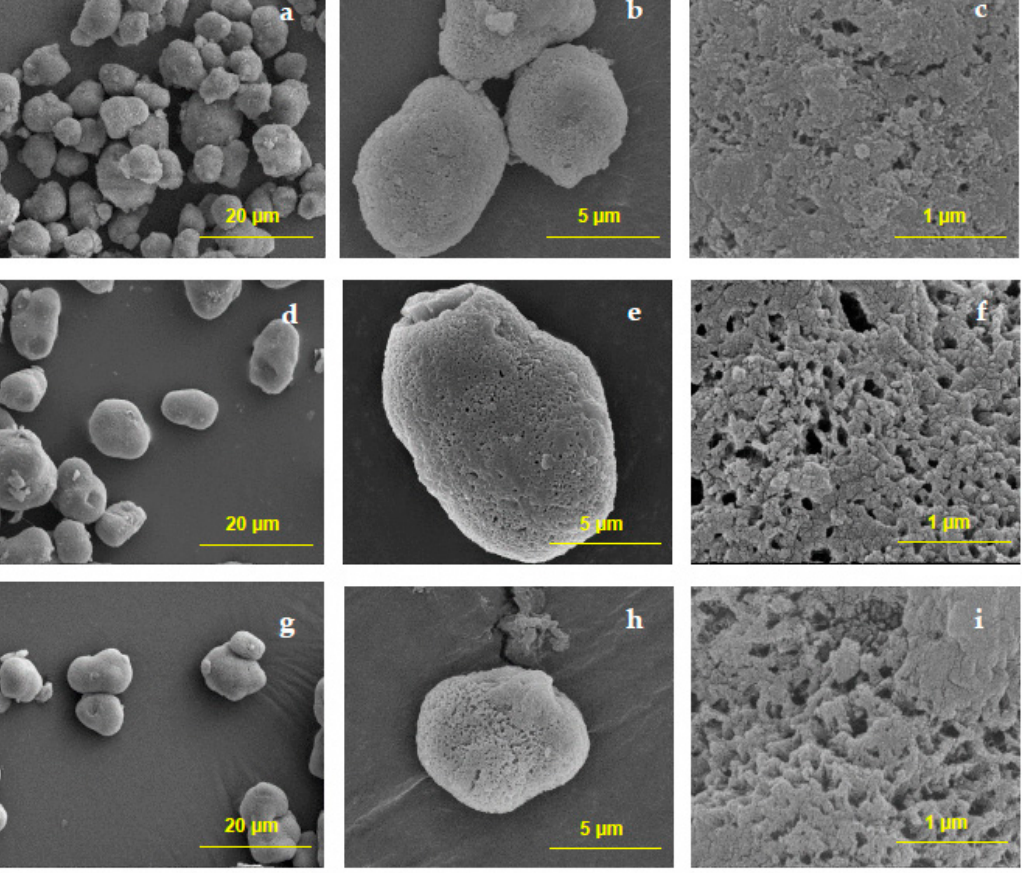
Figure 2. SEM images of laccase-adsorbed PA4@iL: ( a – c ) PA4@iL; ( d – f ) PA4-Fe@iL; ( g – i ) PA4-Fe 3 O 4